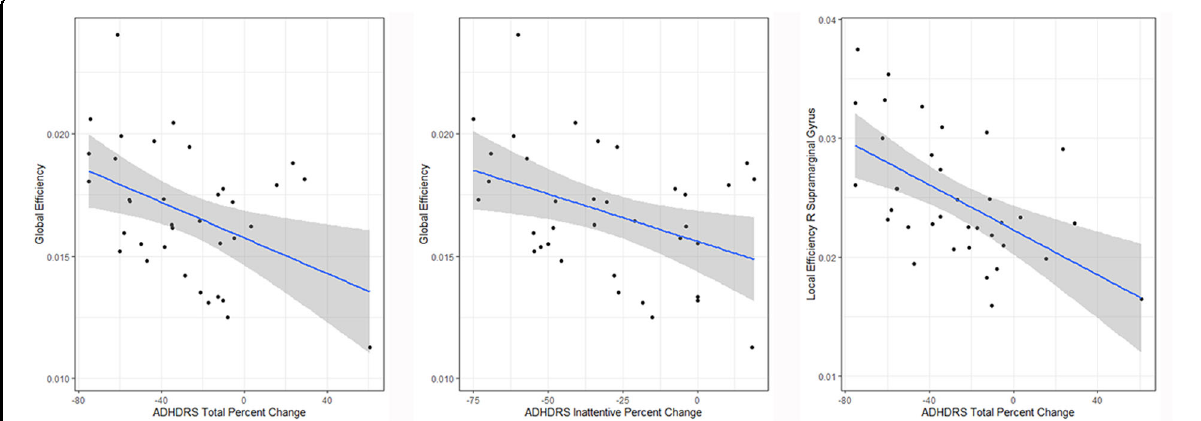
Fig. 2 Scatterplots depicting associations between global ef fi ciency and methylphenidate treatment-related change in ADHD total symptom severity and inattentive symptom severity, and change in ADHD-RS total symptom severity and local ef fi ciency of the right supramarginal